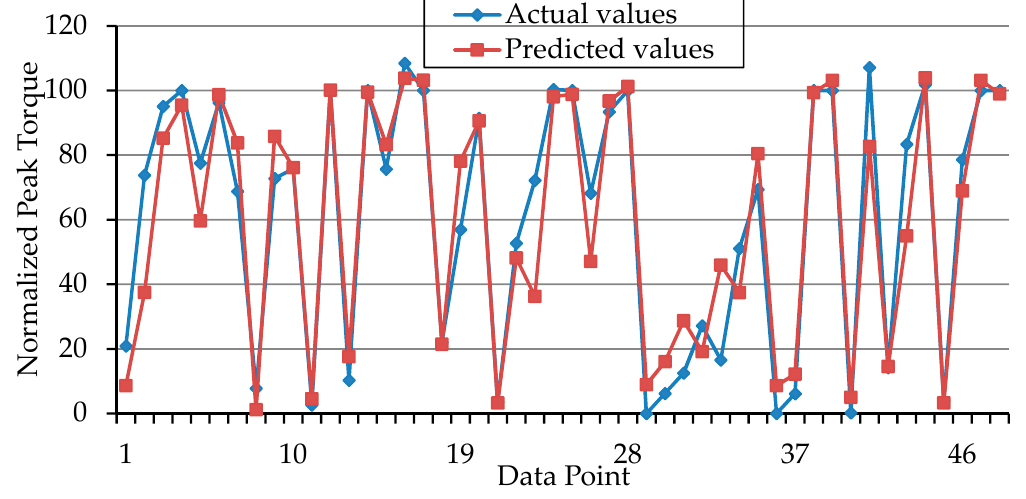
Figure 6. Cross plots of testing set sets—actual vs. predicted values: The plots show the performance